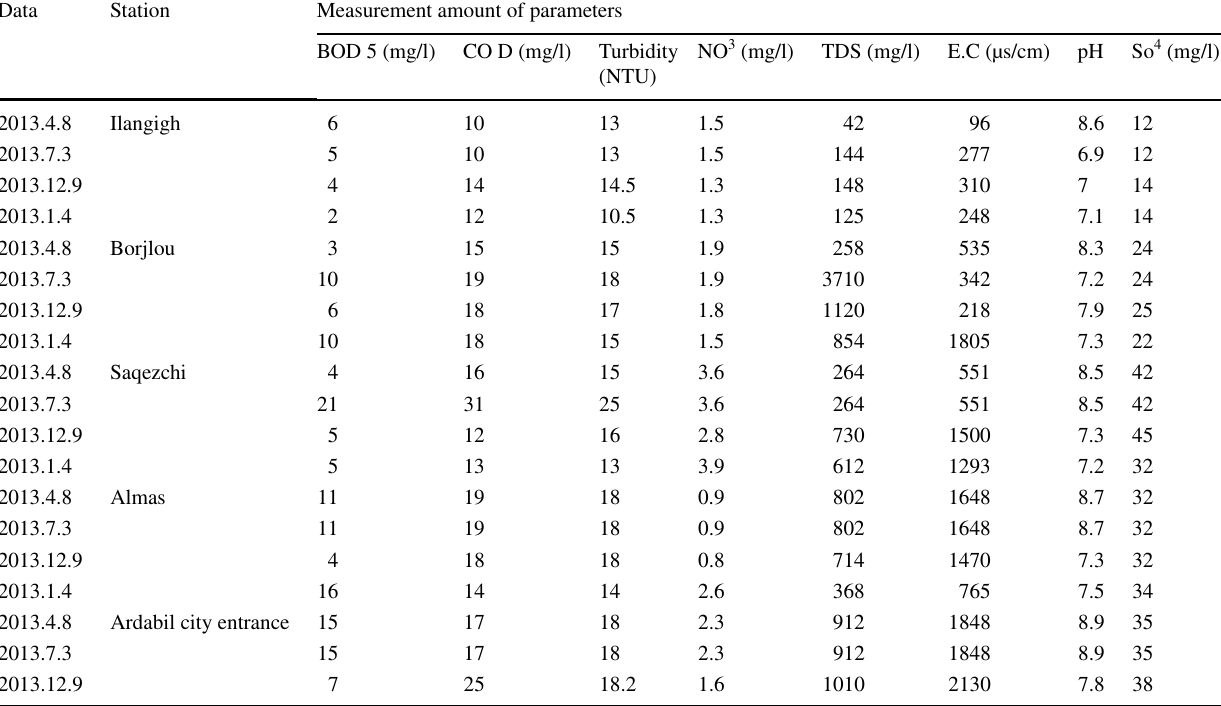
Table 2 Different values of physicochemical parameters in different stations of year